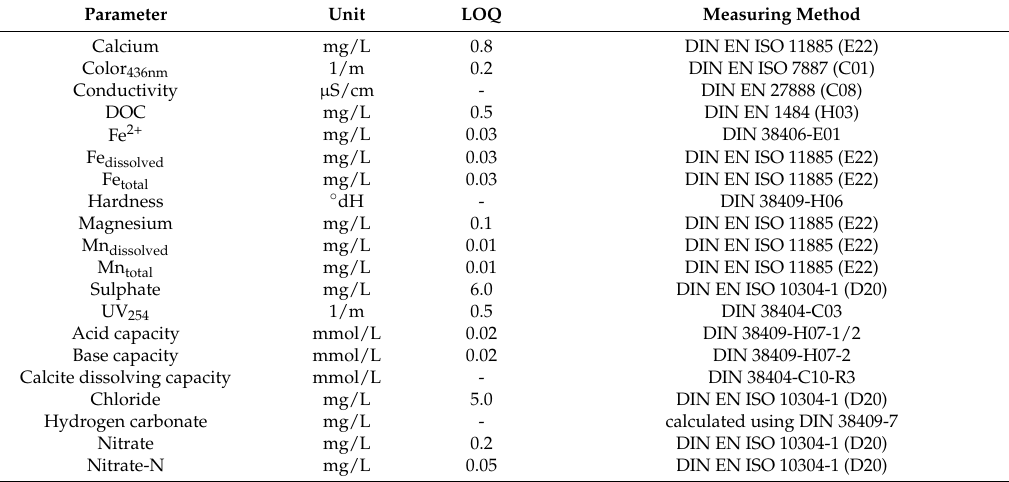
Table A3. Analyzed parameter (manual and laboratory), unit, limit of quantification (LOQ), measuring